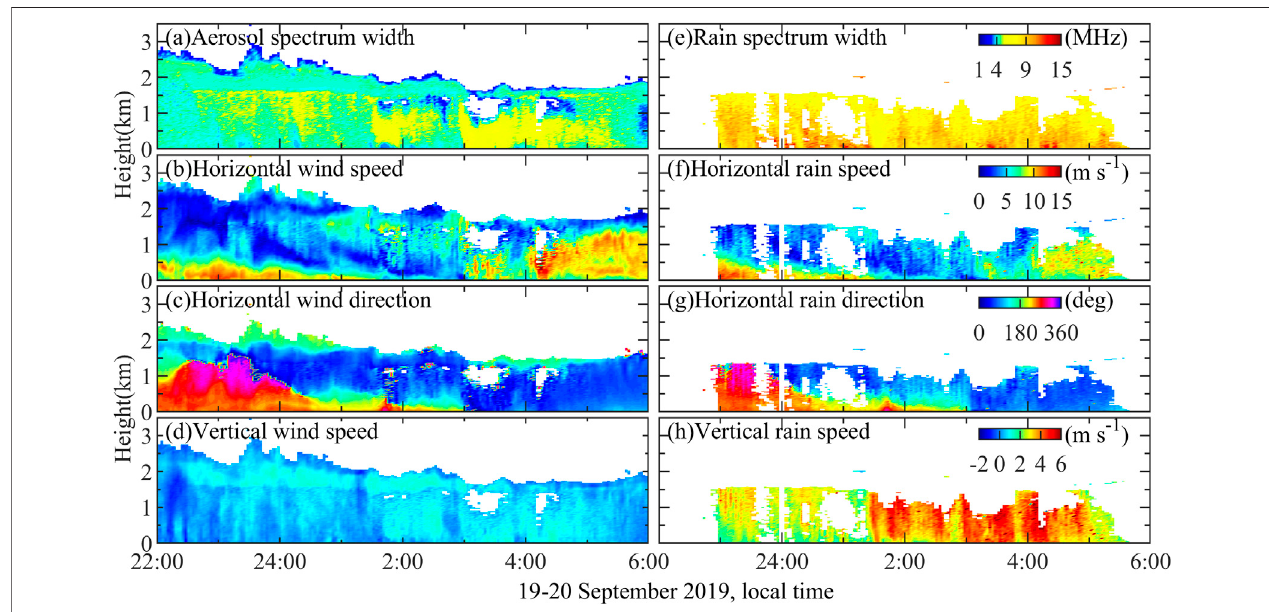
FIGURE 10 | Separation results of wind and rain. (A) Aerosol spectrum width; (B) horizontal wind speed; (C) horizontal wind direction; (D) vertical wind speed; (E) rain spectrum width; (F) horizontal rain speed; (G) horizontal rain direction; (H) vertical rain speed.